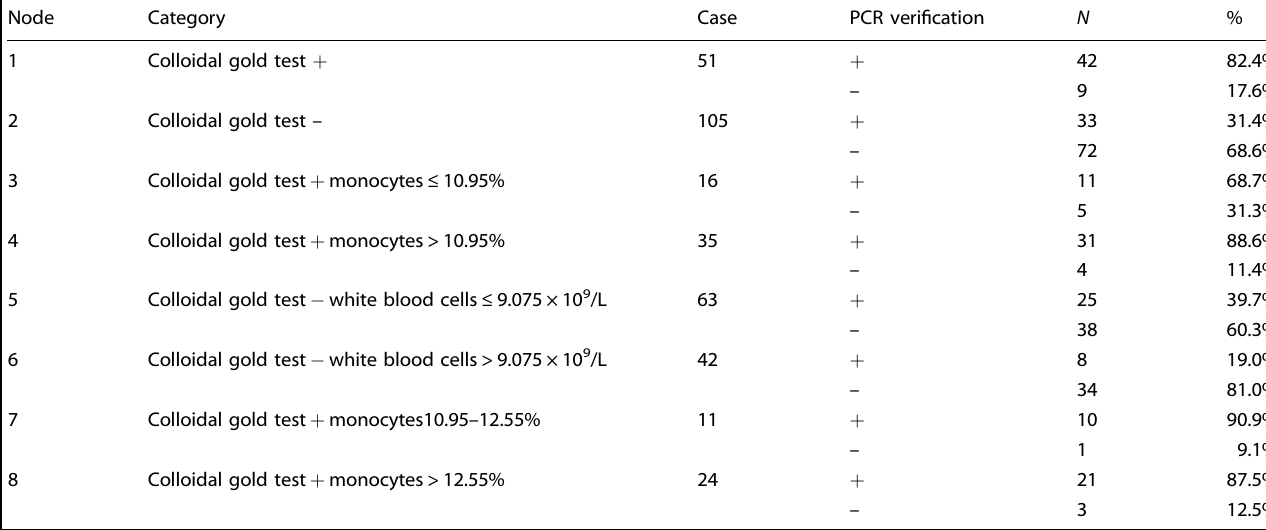
Table 4. Veri fi cation results of the decision tree of 156 in fl uenza-like illness cases in 2019 – 2020. Node